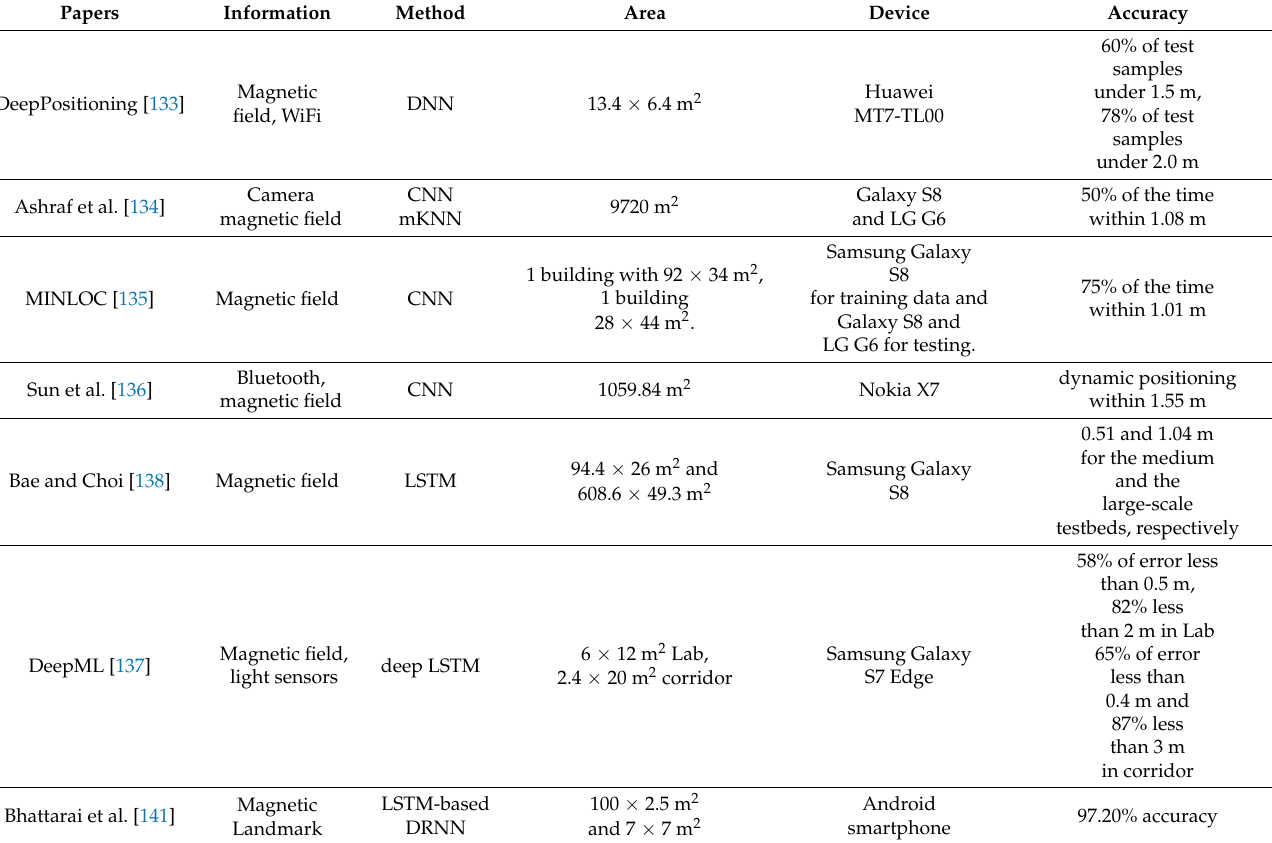
Table 6. Comparison on NN-based localization